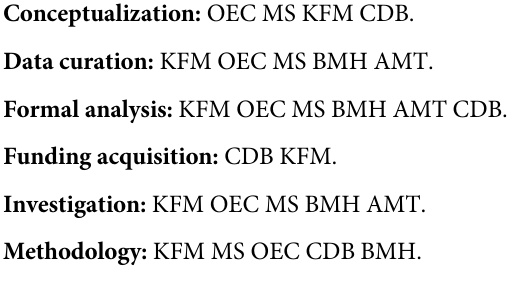
S8 Table. T results for FY (cid:3) O major haplotype. Results for the T MRCA haplotype by population. Results assume 25 year generation time and mutation rate of 1.2 (cid:3) 10 − 8 mutations per basepair per generation. Confidence intervals are calculated from 1000 bootstrapped samples. S9 Table. T results for FY (cid:3) O minor haplotype. Results for the T MRCA haplotype by population. Results assume 25 year generation time and mutation rate of 1.2 (cid:3) 10 − 8 mutations per basepair per generation. Confidence intervals are calculated from 1000 bootstrapped samples. S10 Table. T results for FY (cid:3) A haplotype. Results for the T MRCA Results assume 25 year generation time and mutation rate of 1.2 (cid:3) 10 − 8 mutations per basepair per generation. Confidence intervals are calculated from 1000 bootstrapped samples. S11 Table. Great ape DARC nonsynonymous mutations. All nonsynonymous mutations segregating in the DARC gene region in gorillas, chimpanzees, and bonobos. (PDF) S12 Table. T of Plasmodium vivax genes. MRCA S13 Table. Summary statistics from ABC simulations. The summary statistics of the real FY (cid:3) O data and the simulations from each of the five tested initial frequency models. The per- centages represent the quantiles in the data (Ex. 50% is the median). S14 Table. Summary statistics from ABC simulations for fixed selected alleles. The sum- mary statistics of the real FY (cid:3) O data and the simulations from each of the five tested initial fre- quency models where the selection allele fixed in the population. The percentages represent the quantiles in the data (Ex. 50% is the median). S15 Table. Information gain statistics of features from 0.1% initial frequency simulation.